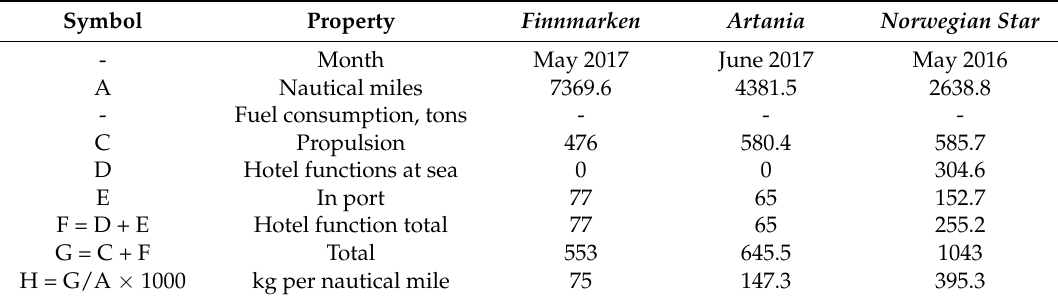
Table 11. Estimates for validation period with load estimates from Finnmarken data and specific fuel consumption from